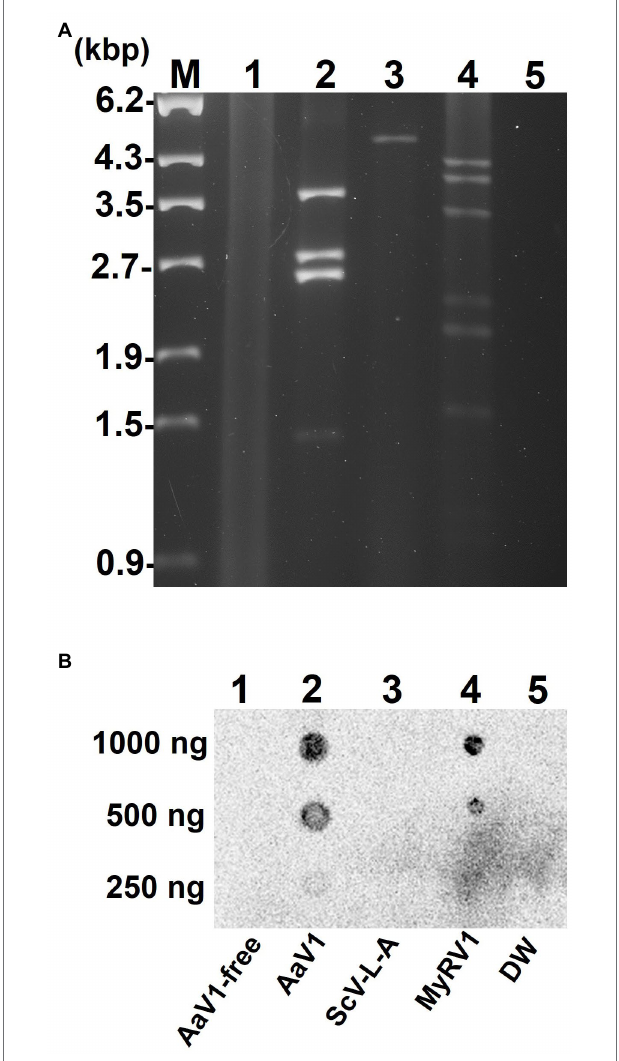
FIGURE 1 | Detection of the 5 ' cap structures in the AaV1 dsRNA genome by RNA dot blot with the anti-m 7 G-Cap mAb. (A) Viral dsRNAs from